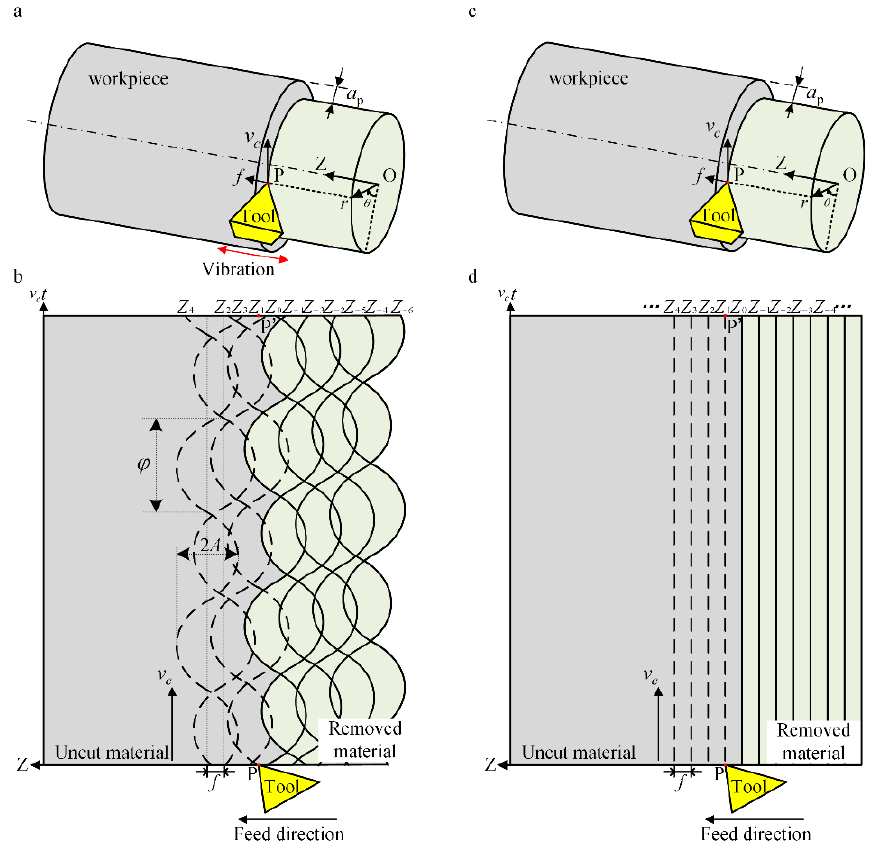
Figure 1. Schematics for the comparison of HUVC and CC: ( a ) HUVC during turning, ( b ) HUVC trajectories on the workpiece surface during turning, ( c ) CC during turning, and ( d ) CC trajectories on the workpiece surface during turning. v c , cutting speed, f , feed per revolution, A , ultrasonic vibration amplitude, a p , depth of cut, ϕ , phase shift, r, θ , Z